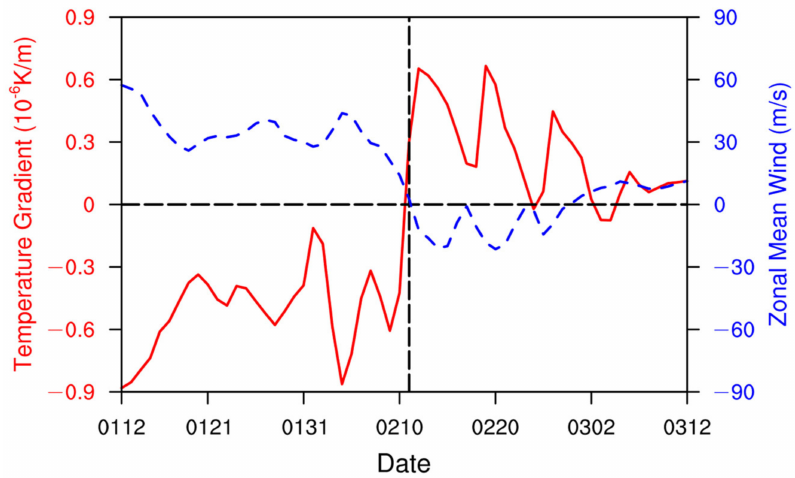
Figure 1. The evolution of 10 hPa temperature gradient between 60 ◦ N and 90 ◦ N (solid line) and zonal mean wind at 60 ◦ N and 10 hPa (dashed line) from 12 January 2018 to 12 March 2018. The vertical dashed line denotes the onset date of the SSW event (i.e., 11 February); the horizontal dashed line represents the zero-contour line.